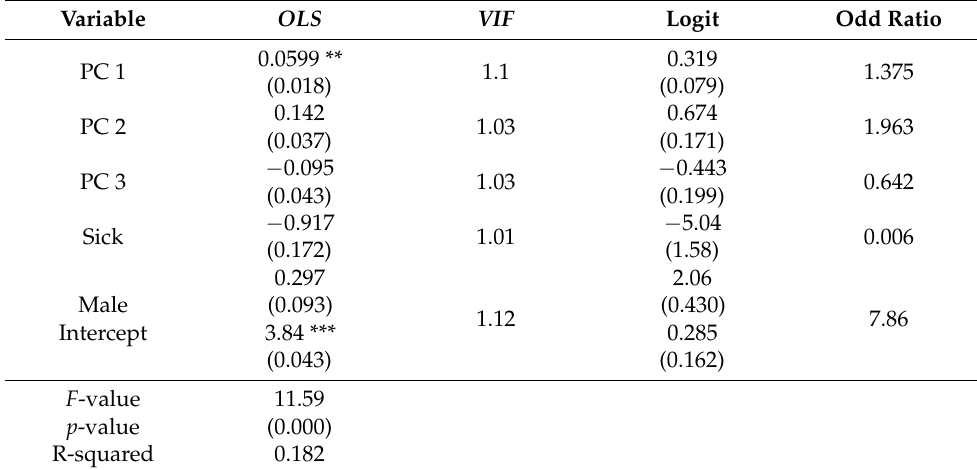
Table A5. Principal components regression results for Mood with Sick and Male as controls.